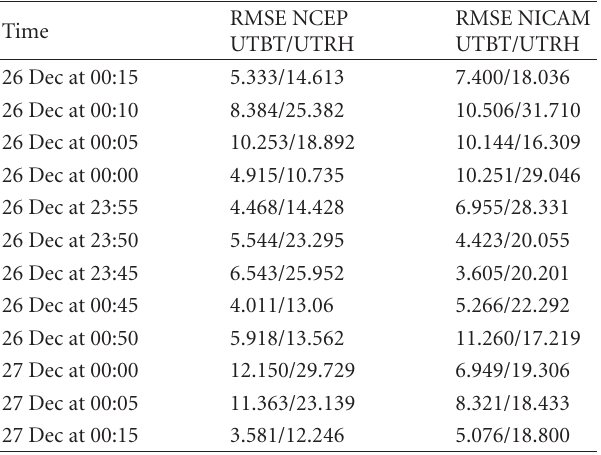
Table 2: RMSE (root mean square error) between the observation data and the NCEP/DOE, then the NICAM UTBT (TB6.7) and UTRH during the year 2006. NCEP represents the NCEP/DOE